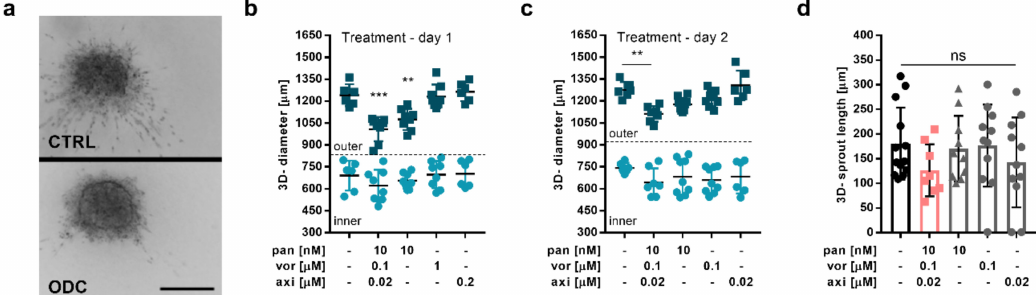
Figure 3. Inhibition of cell migration cultivated in 3-D spheroids. ( a ) Representative images of 3-D homotypic spheroids composed of Caki-1 cells cultured in a low attachment plate in 0.5 mg / mL collagen type I and treated with the CTRL (0.03% DMSO in culture medium, top image) and the multidrug combination (ODC, bottom image). Scale bar = 200 µ m. The impact of the treatment conditions applied on ( b ) day 1 (24 h after seeding; N = 3) and ( c ) on day 2 (48 h after seeding; N = 3) on the spheroid growth was measured through the size of the diameter. ( d ) Treatment e ff ect on the sprout length, ( N = 3). Error bars represent the SD and significance was determined with a one-way ANOVA and is represented with ** p < 0.01 and *** p < 0.001. ns, not